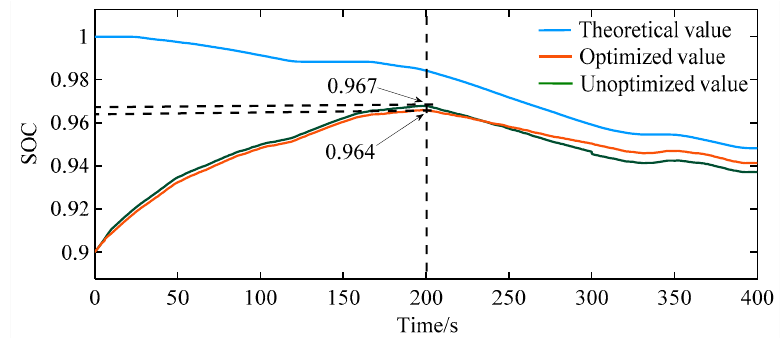
Figure 17. The comparison of the estimation values in the first 400 s.